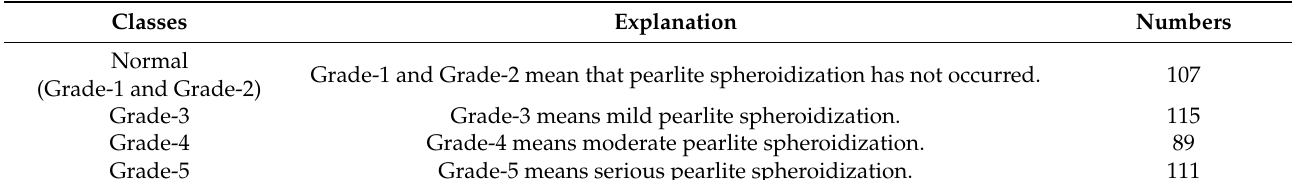
Table 2. Image numbers for spherular pearlite gradation with each class.